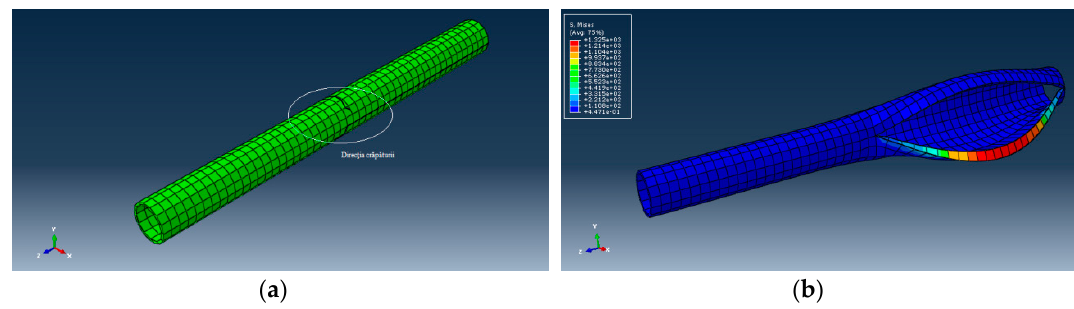
Figure 28. Displacements of the nodes at the crack for the pipes DN315.